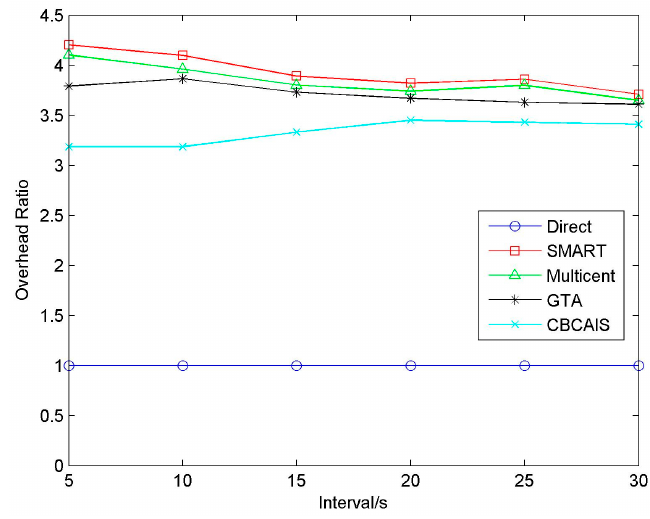
Figure 19. Overhead ratio for varying message generation interval.